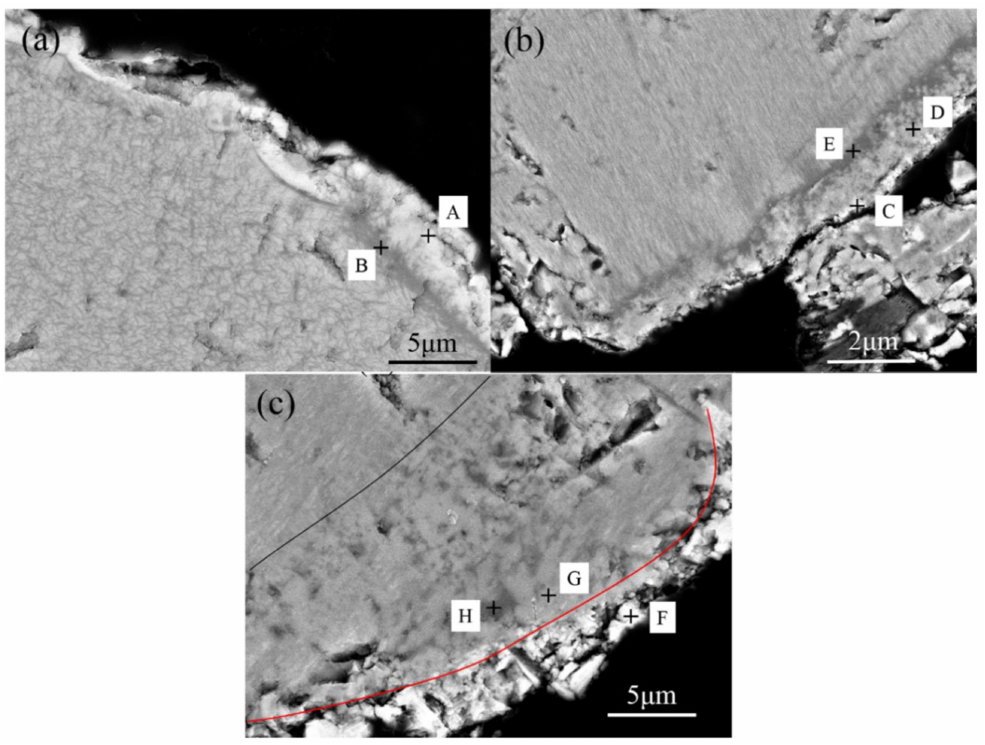
Figure 9. Microstructure of oxidation roasting ilmenite for ( a ) ilmenite A0 oxidized at 800 ◦ C for 60 min, ( b ) ilmenite A0 roasted at 900 ◦ C for 30 min after it was oxidized at 800 ◦ C for 60 min and ( c ) ilmenite A0 roasted at 900 ◦ C for 60 min after it was oxidized at 800 ◦ C for 60 min.